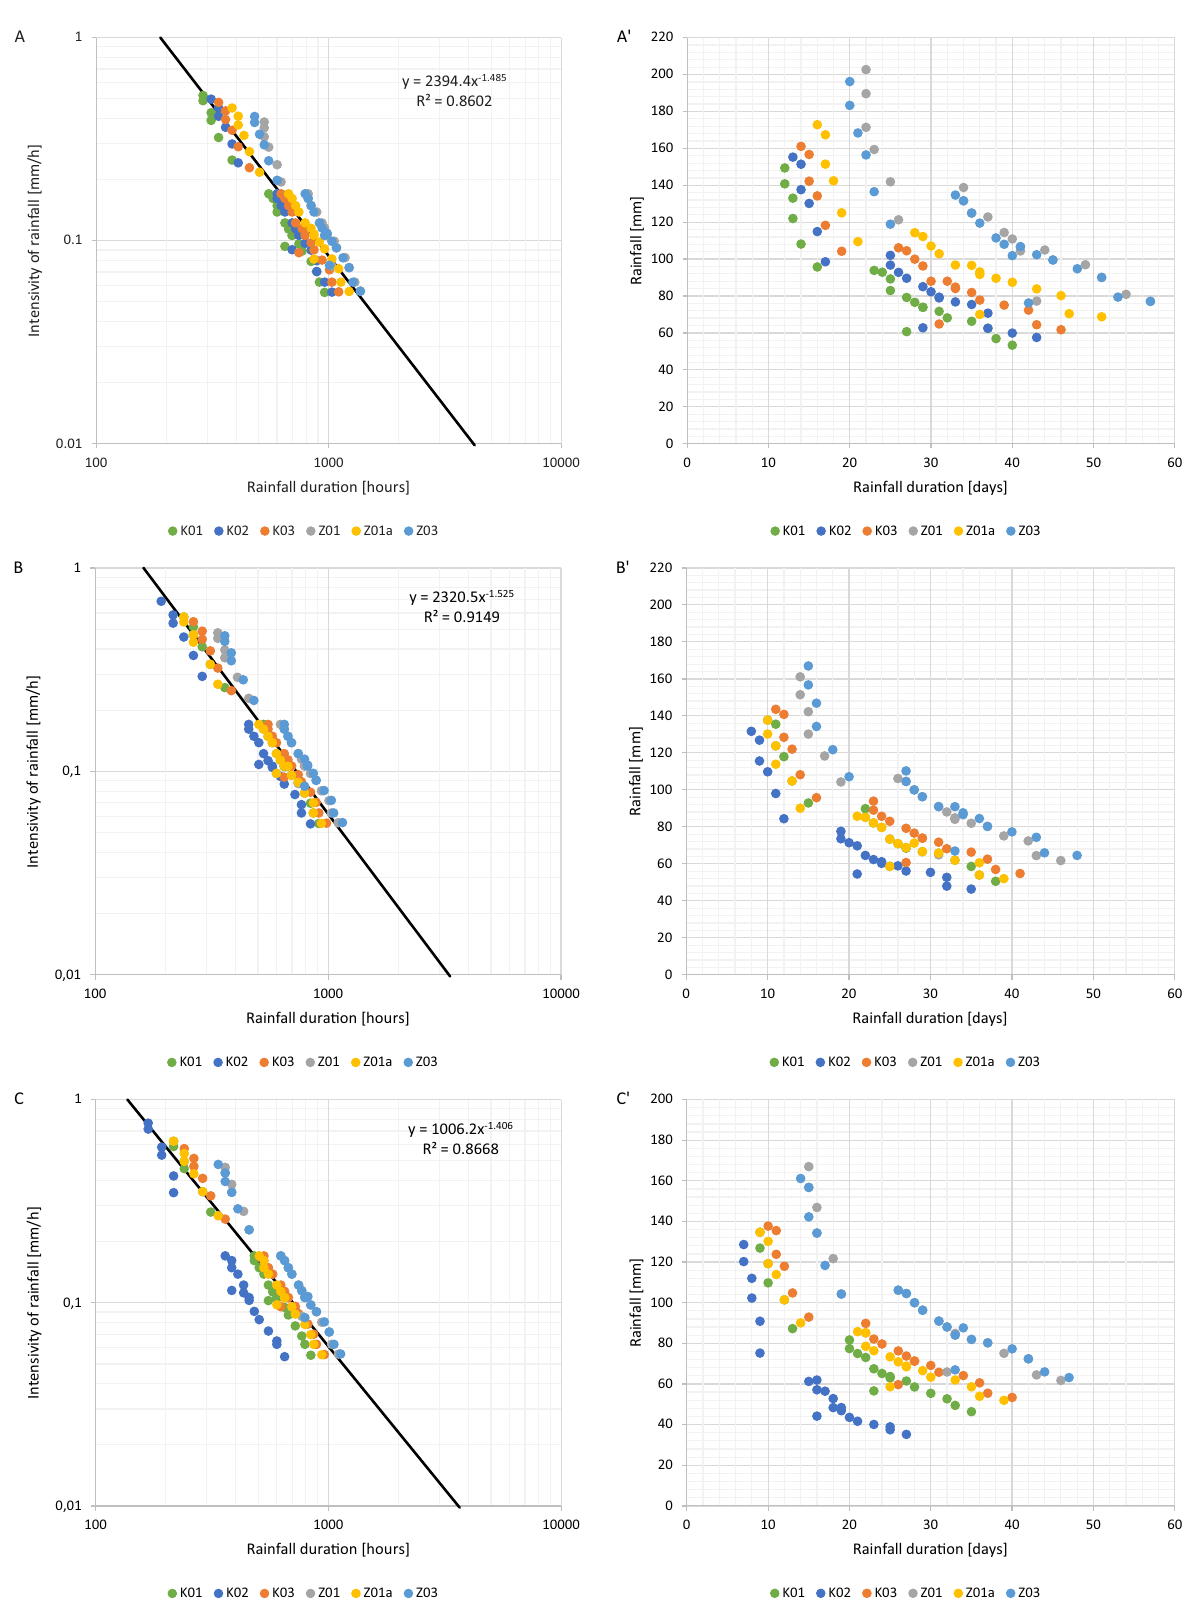
Fig. 13. Threshold precipitation values based on calculations of slope stability of the western part of the Nałęczów Plateau. intensity–duration thresholds: A-A’ – dry slope on the first analysis day; B-B’ – humid slope on the first analysis day; C-C’ – wet slope on the first analysis